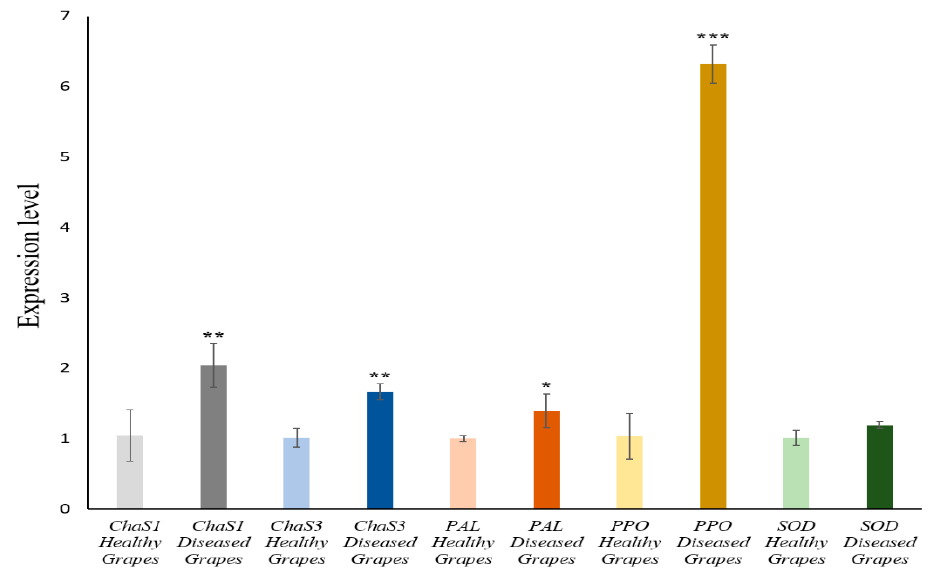
Figure 5. Transcript accumulation in grapevine healthy leaves vs. esca-diseased grapes, from October. Quantitative PCR in ChaS , ChaS3 , PAL , PPO , and SOD of both types (healthy and esca-diseased plants) to quantify ChaS , ChaS3 , PAL , PPO and SOD transcripts. Significant differences by Student’s t-test between each transgenic line and Col-0 are marked (* p < 0.05; ** p < 0.05 ∩ p ≥ 0.001; *** p < 0.001).